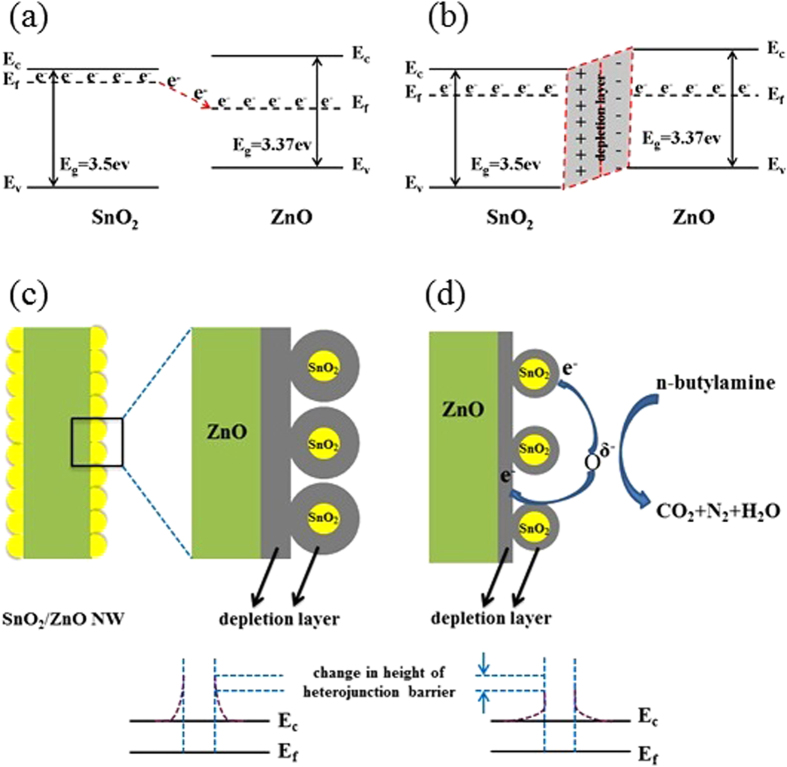
(a,b) The energy band structures and (c,d) gas sensing mechanisms of the SnO2/ZnO NW heterostructure sensor.